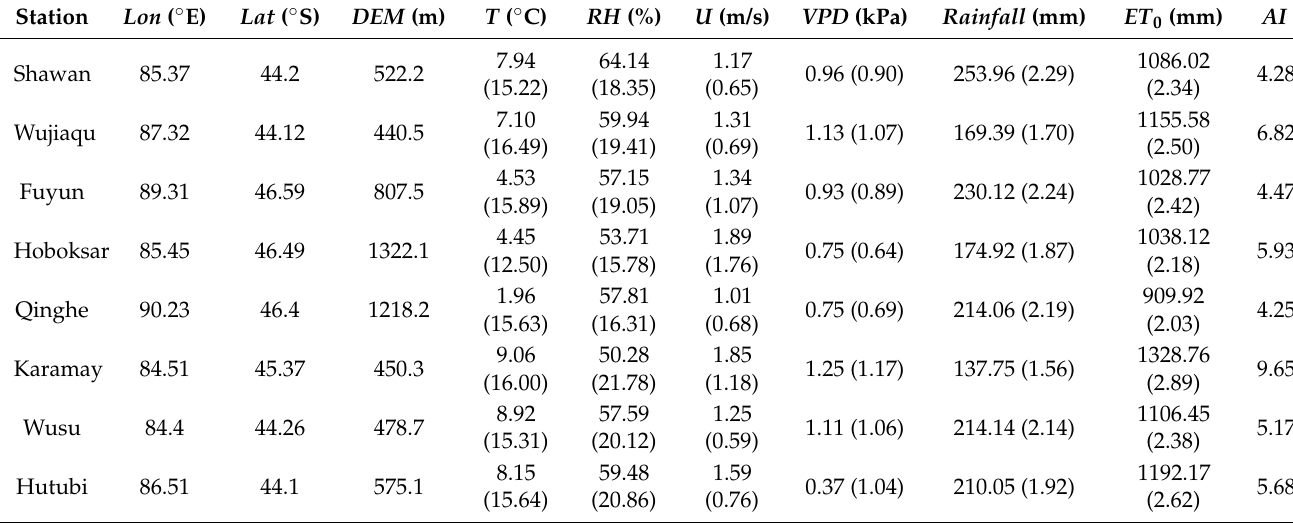
Figure 1. Geographical locations of Gurbantunggut Desert and meteorological stations. Table 1. Geographical and long-term average meteorological information for 8 stations in Gurbantunggut Desert, Xingjiang, China. The values in parentheses are the standard deviations for each variable. Station Lon (°E) Lat (°S) DEM (m)